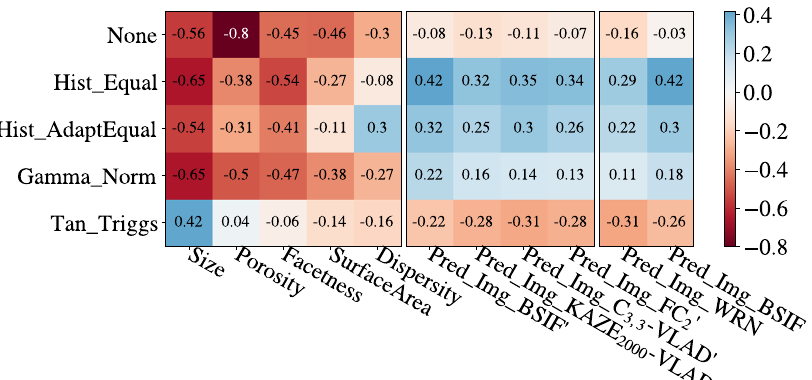
Fig. 6 Correlations between lot averaged intensity ( <I> ) and lot microstructure characteristics (1st to 5th column), and correlations between image intensity ( I ) and image UCS predictions (6th to 11th column). The fi rst fi ve columns and the last two columns were evaluated on the full image set. The traditional ML models (middle four columns) were evaluated on a 6000-image subset and are denoted with primes.